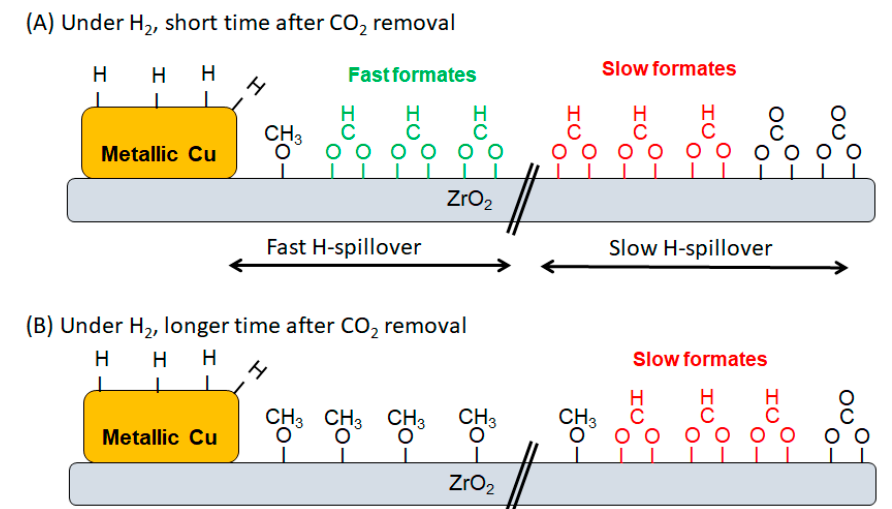
Figure 7. Schematic representation of the evolution of the ZrO 2 ‐ bound formates under H 2 . See text for more details.